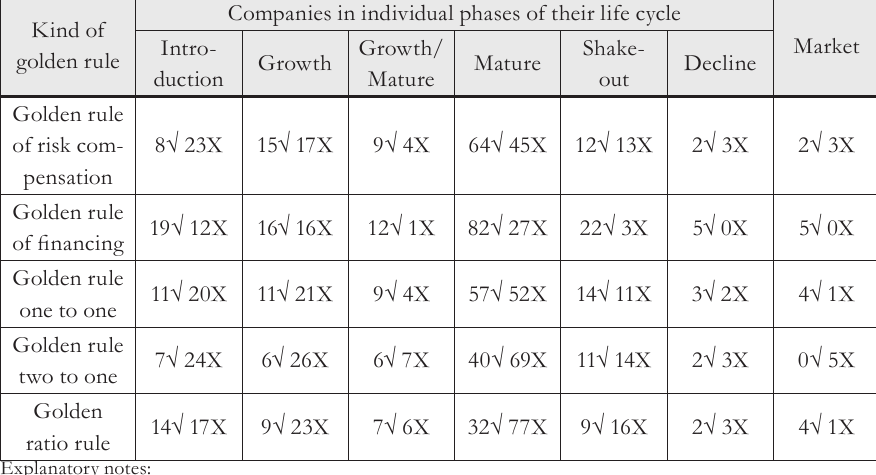
Tab. 3 – Respecting (or not respecting) golden rules of financing depending on the corporate life cycle and comparison with their respecting (or not respecting) on the whole market. Source: own